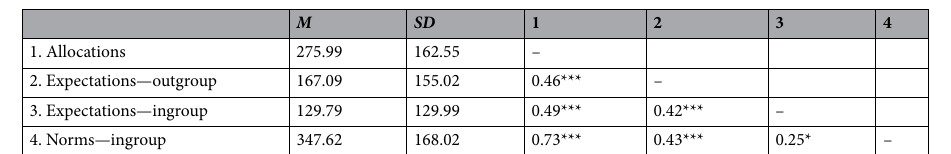
Table 2. Means (M), standard deviations (SD) and correlations between allocations to collective account, expectations of others’ allocations to this account, and prescriptive norms (Study 2). *** p < 0.001.